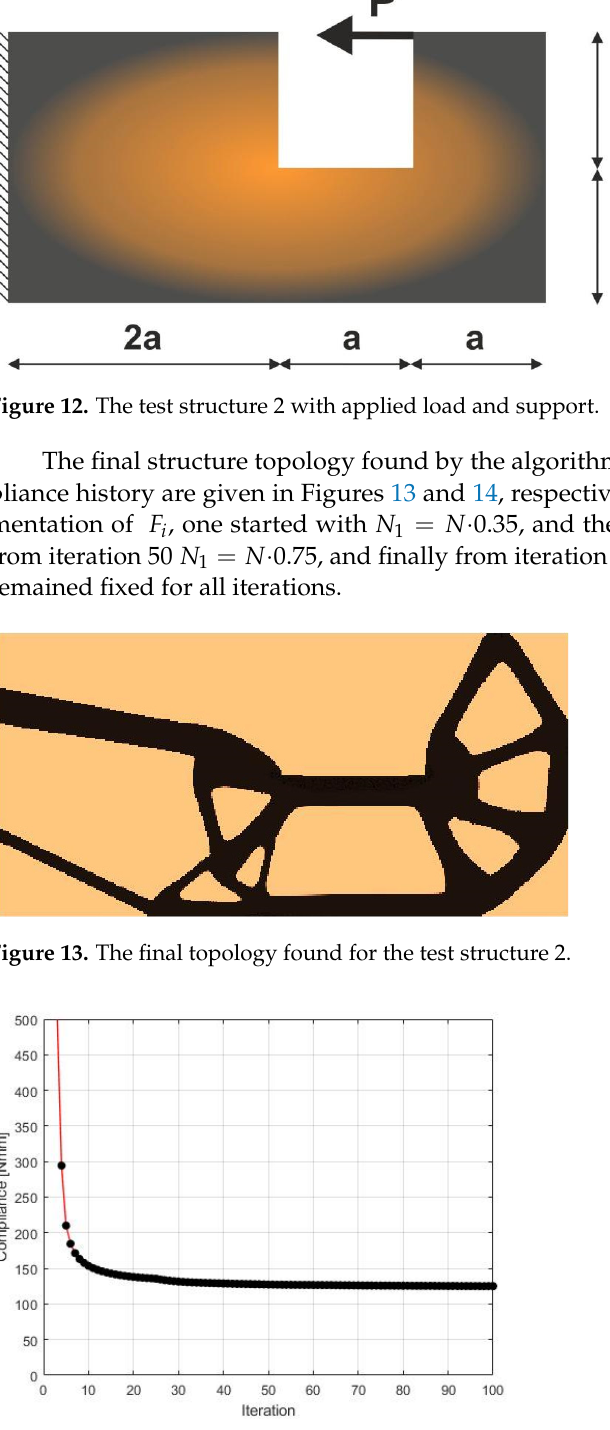
Figure 11. The compliance history for the test structure 1. Minimal value: 151.84 Nmm. Black dots on the red line represent the compliance values for subsequent iterations.